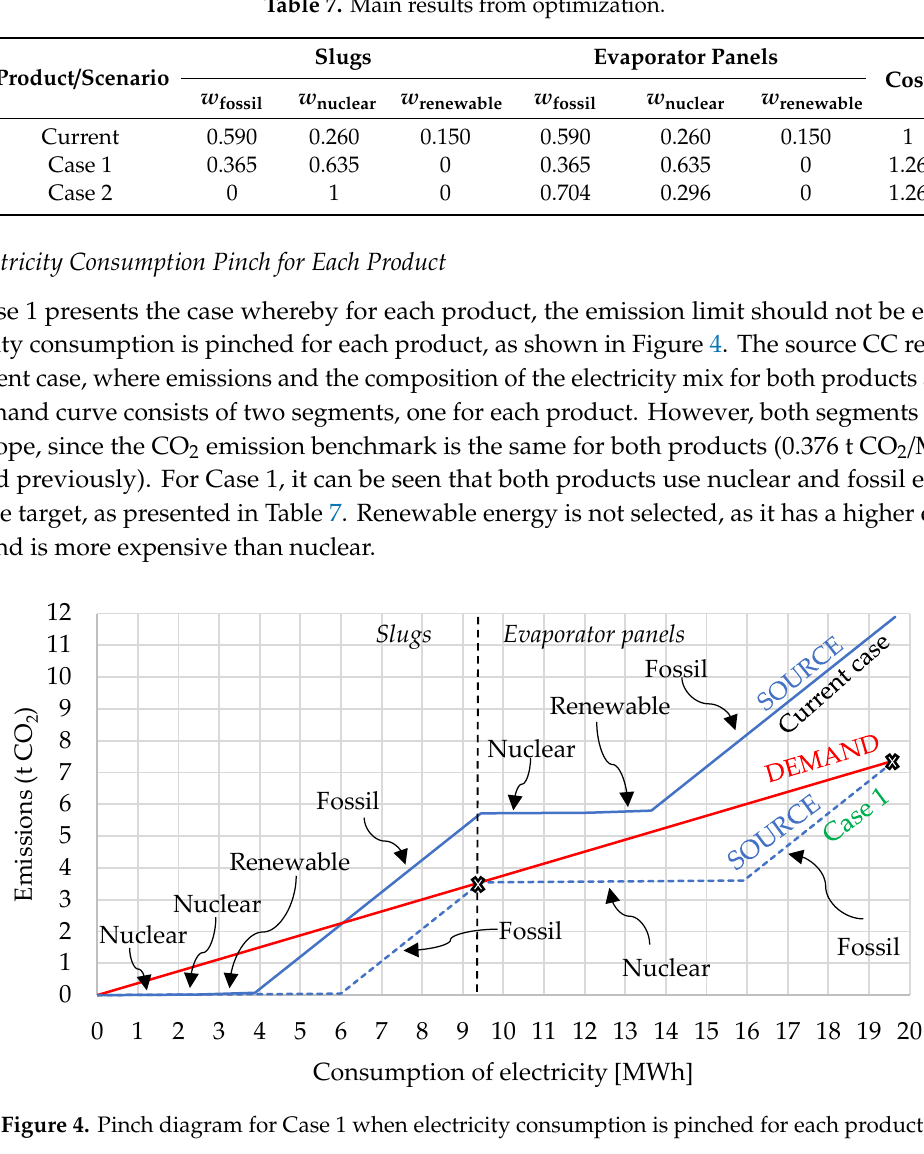
Table 7. Main results from optimization.